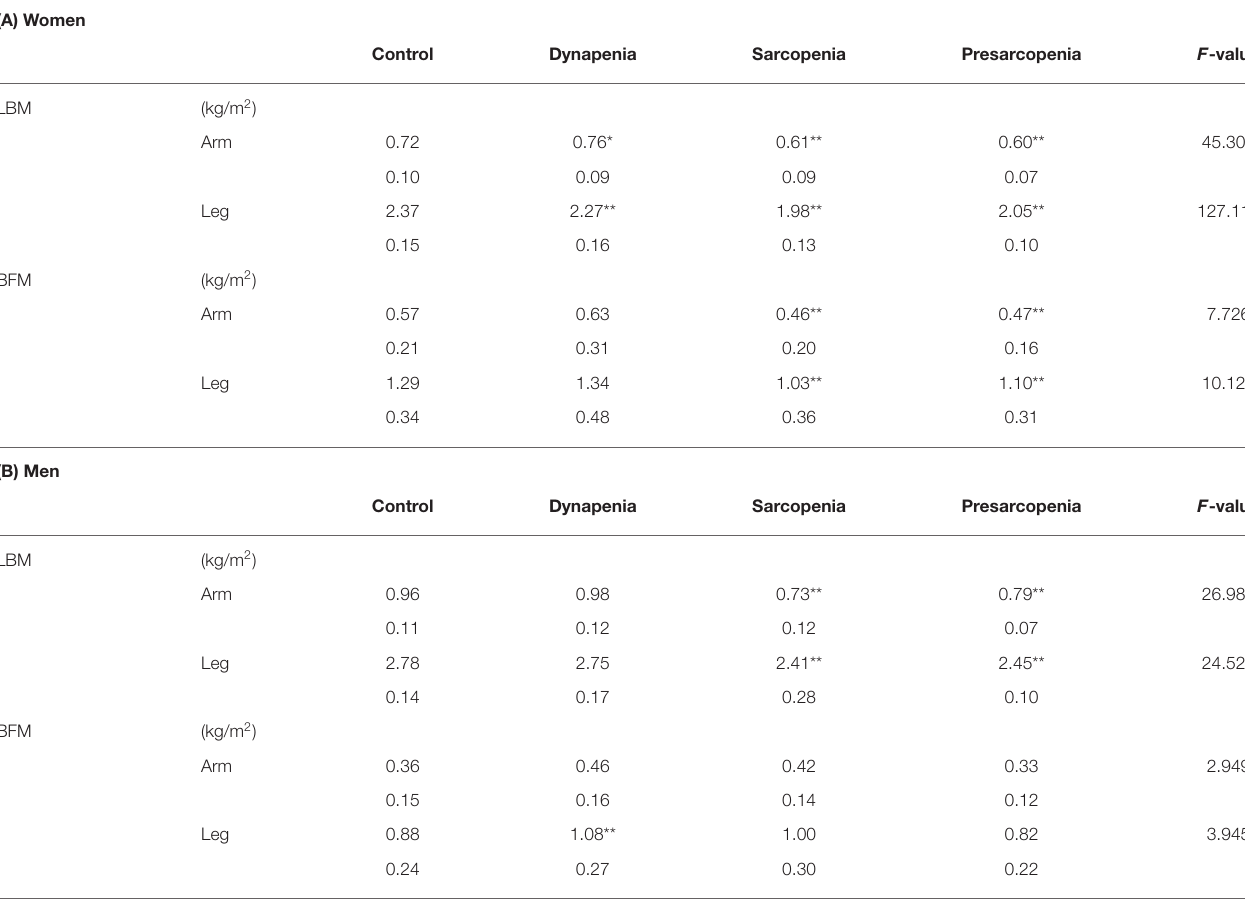
TABLE 2 | Body composition for each sarcopenia